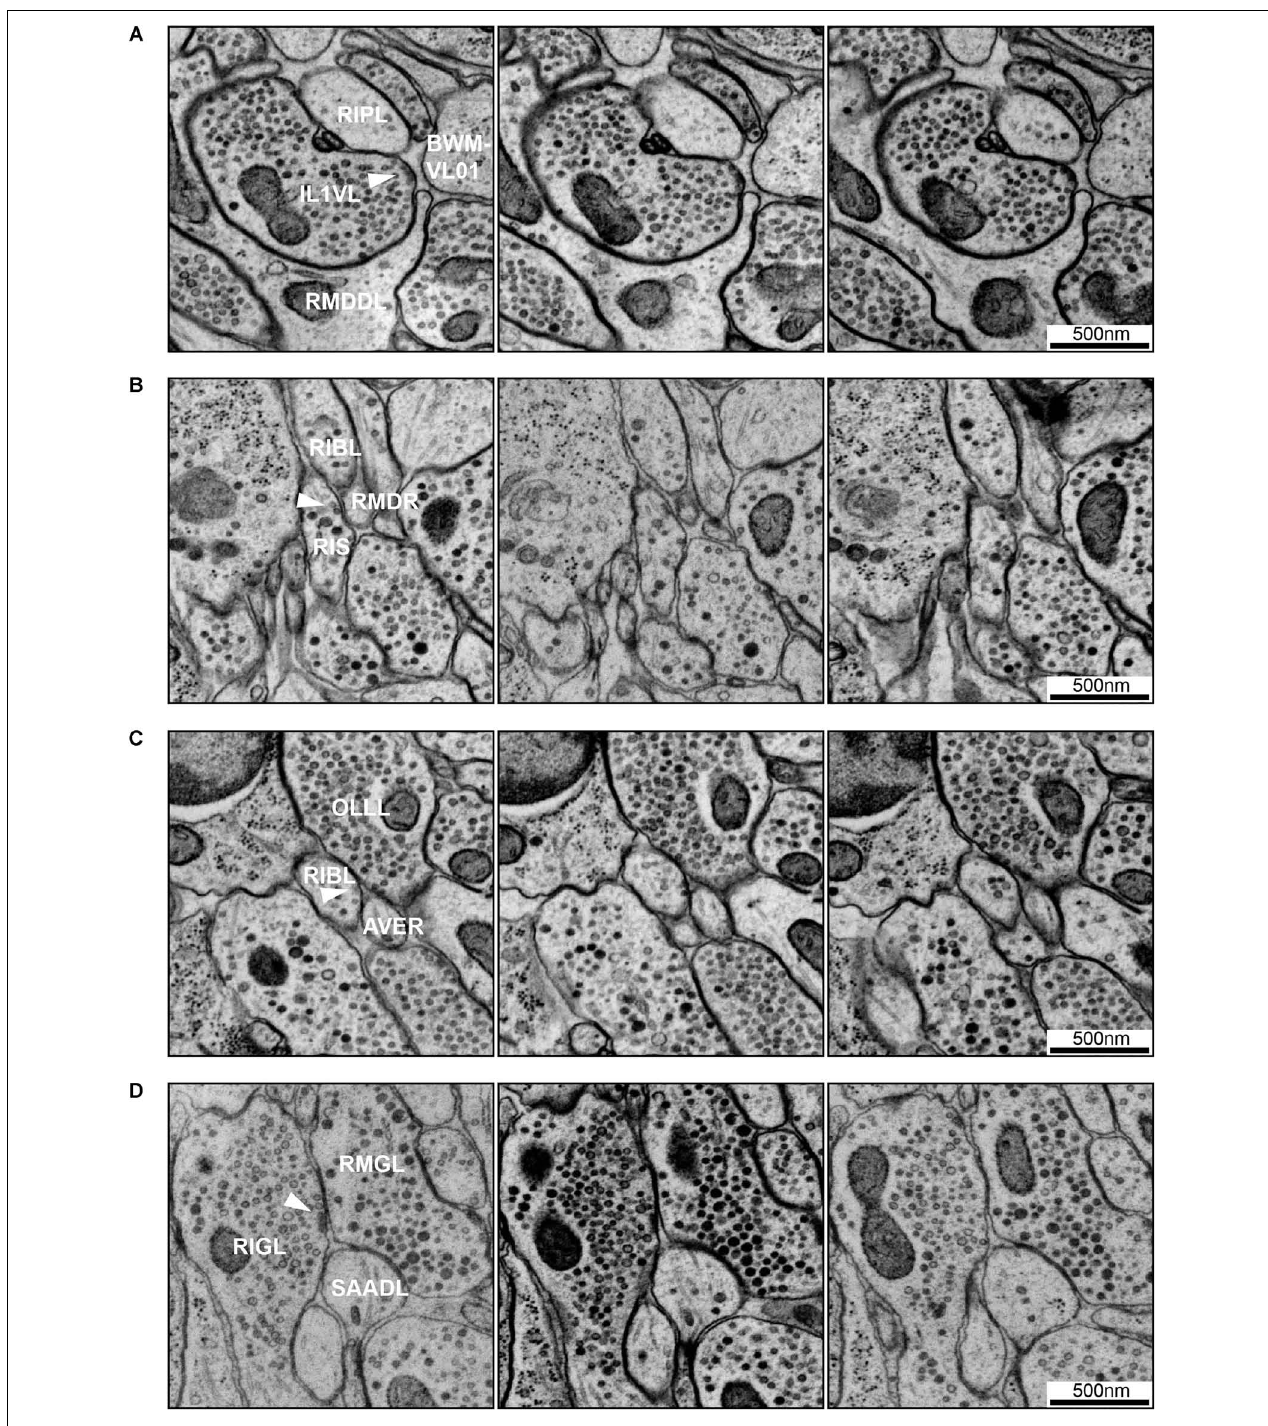
FIGURE 7 | Examples of synapse annotation with different degrees of subjectivity. (A) Serial sections through a large, confidently annotated polyadic synapse (from IL1VL to RIPL, RMDDL and body wall muscle BWM-VL01). This synapse spans these three sections, and beyond (not shown). (B) Serial sections through a very small synapse (from RIS to RIBL and RMDR). The annotation of this synapse is less confident that the one presented in panel (A) . (C) Serial sections of a membrane swelling that is confidently annotated as not-a-synapse. A small density in the membrane of RIBL with sparse vesicles is not a presynaptic specialization. (D) Serial sections through a synapse showing the occasional subjectivity involved in defining postsynaptic partners. While all annotators agreed RMGL was a postsynaptic partner of RIGL, whether SAADL should be included as a postsynaptic partner was cause for debate. White arrowheads indicate the membrane of interest. Scale bars are 500 µ